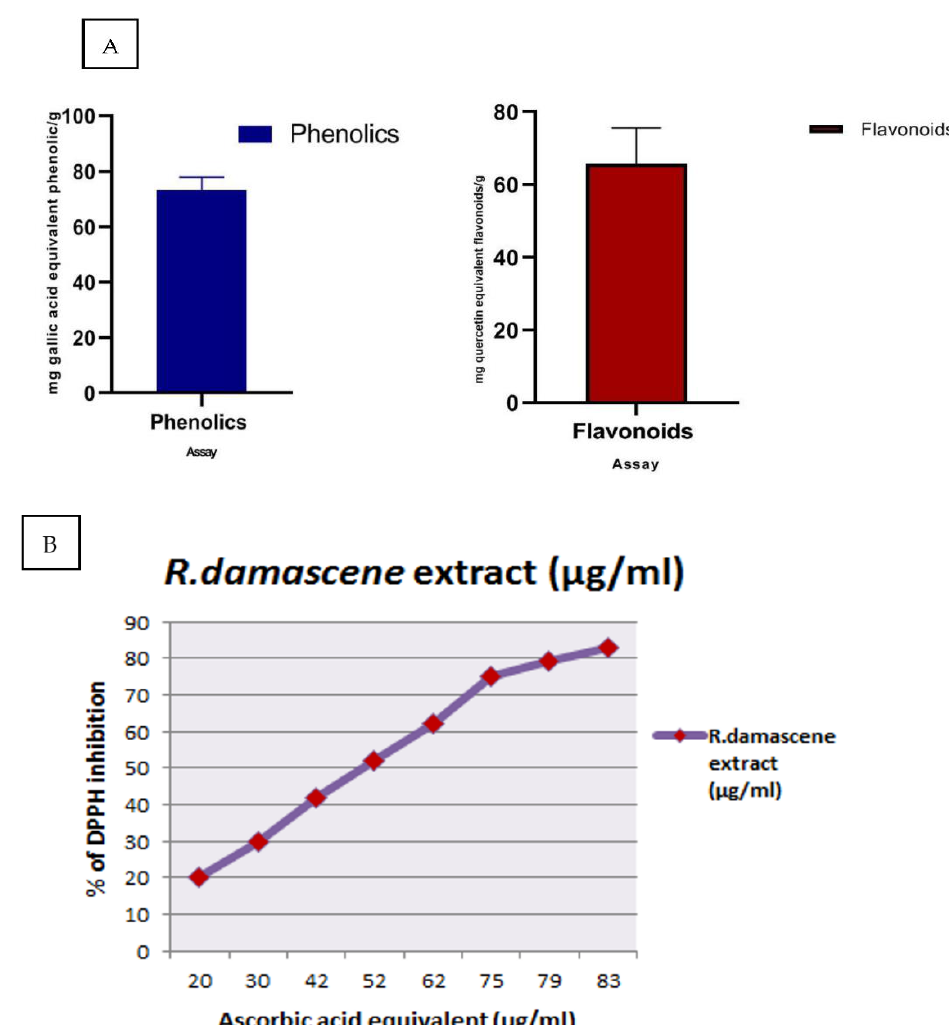
Figure 2. ( A ) Total phenolics and flavonoid content; ( B ) scavenging activity of R. damascena against DPPH. Data are expressed as mean ± SE.